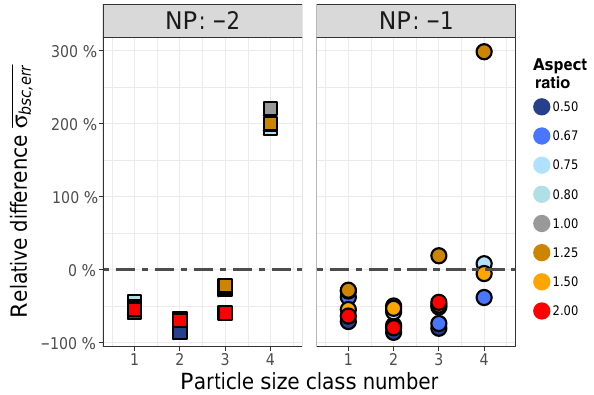
Figure 11. The same as Fig. 10 but for the effective backscatter cross section. The maximum relative difference between the effec- tive backscatter cross section of spherical and non-spherical parti- cles are observed for size class 2 with a relative difference of up to − 80% (resulting in a difference factor of 5). Even for other size classes, the relative difference is about a factor of 2 when assuming spherical shape for the considered non-spherical particle shapes.